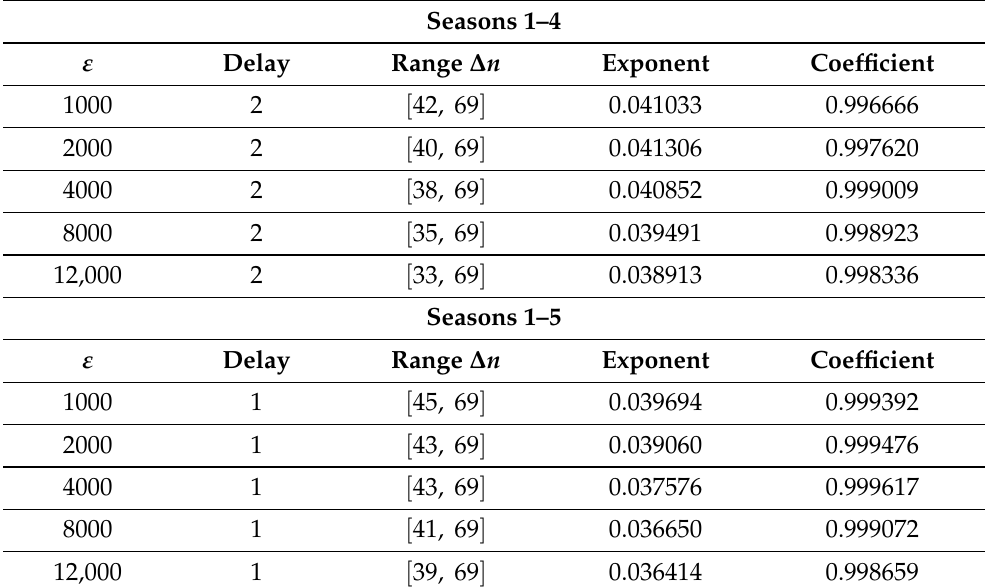
Table 8. Maximal Lyapunov exponents for coop3 (seasons 1–4 and